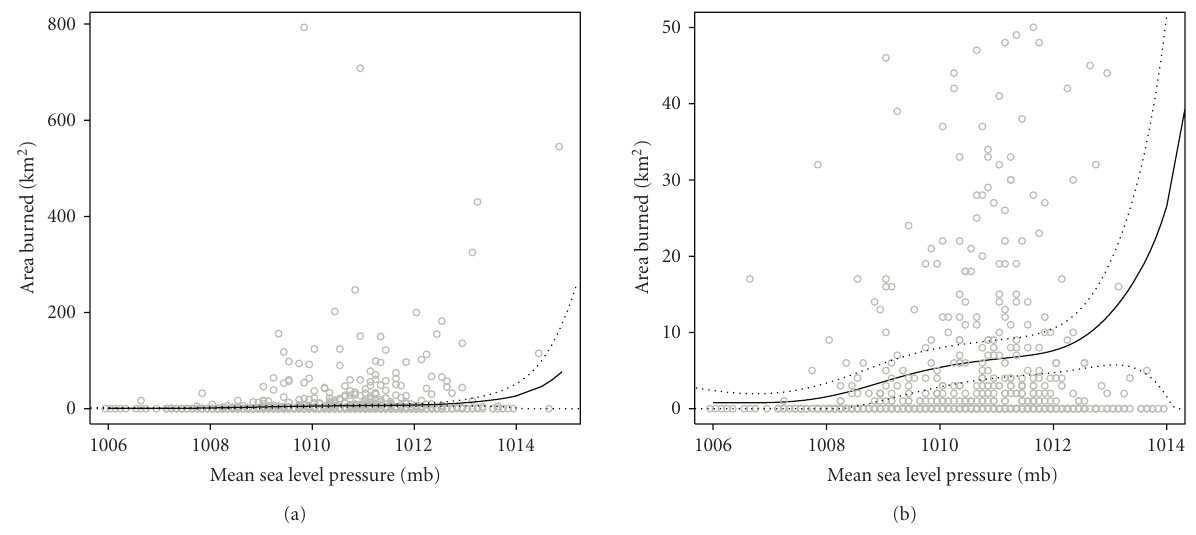
Figure 2: Estimate (solid line) of total area burned (km 2 ) per day by mean sea level pressure, smoothed using a Gaussian kernel smoother and bandwidth of 0.8 millibars, calculated by modified likelihood cross-validation. 95% confidence limits (dotted lines) of the smoothed estimate are also shown. (a) All the data are shown, (b) only days with burn areas less than 50 km 2 are shown.